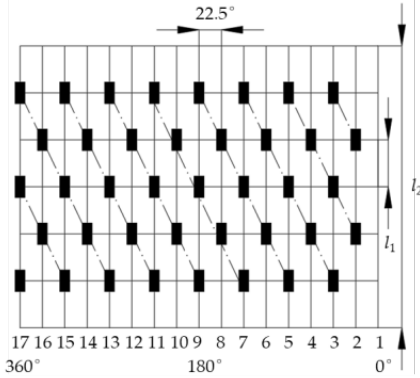
Figure 4. Two-dimensional representation of convex geometrical structure on press roller.